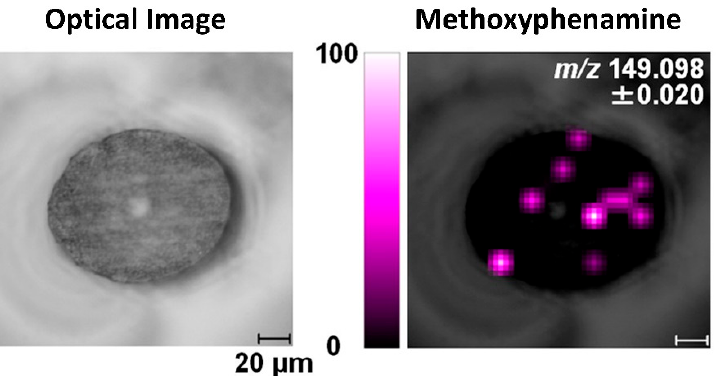
Figure 5. Image of methoxyphenamine in a cross-sectioned hair strand analyzed by MALDI-ion trap TOF MS/MS. The hair is embedded in gelatin, and the spatial resolution is 10 µm. Reprinted with permission from [50]. Copyright (2021) American Chemical Society.